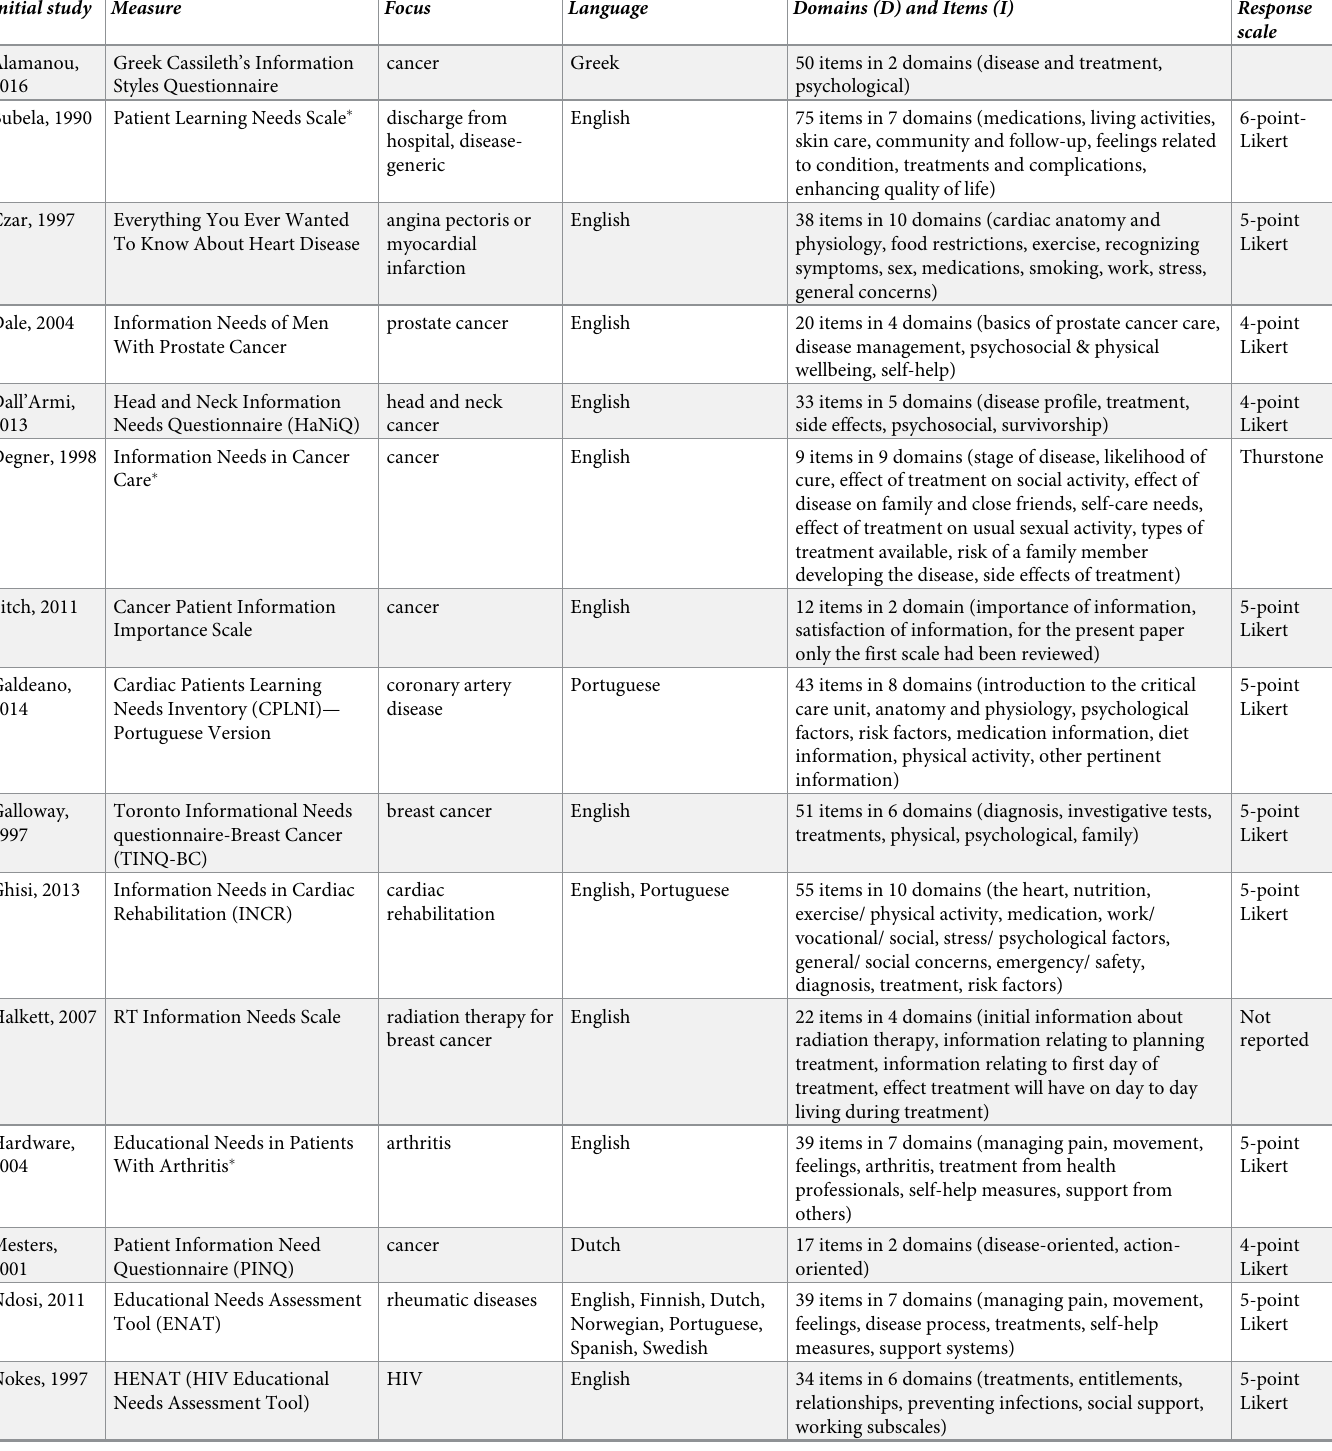
Table 4. Characteristics of information needs